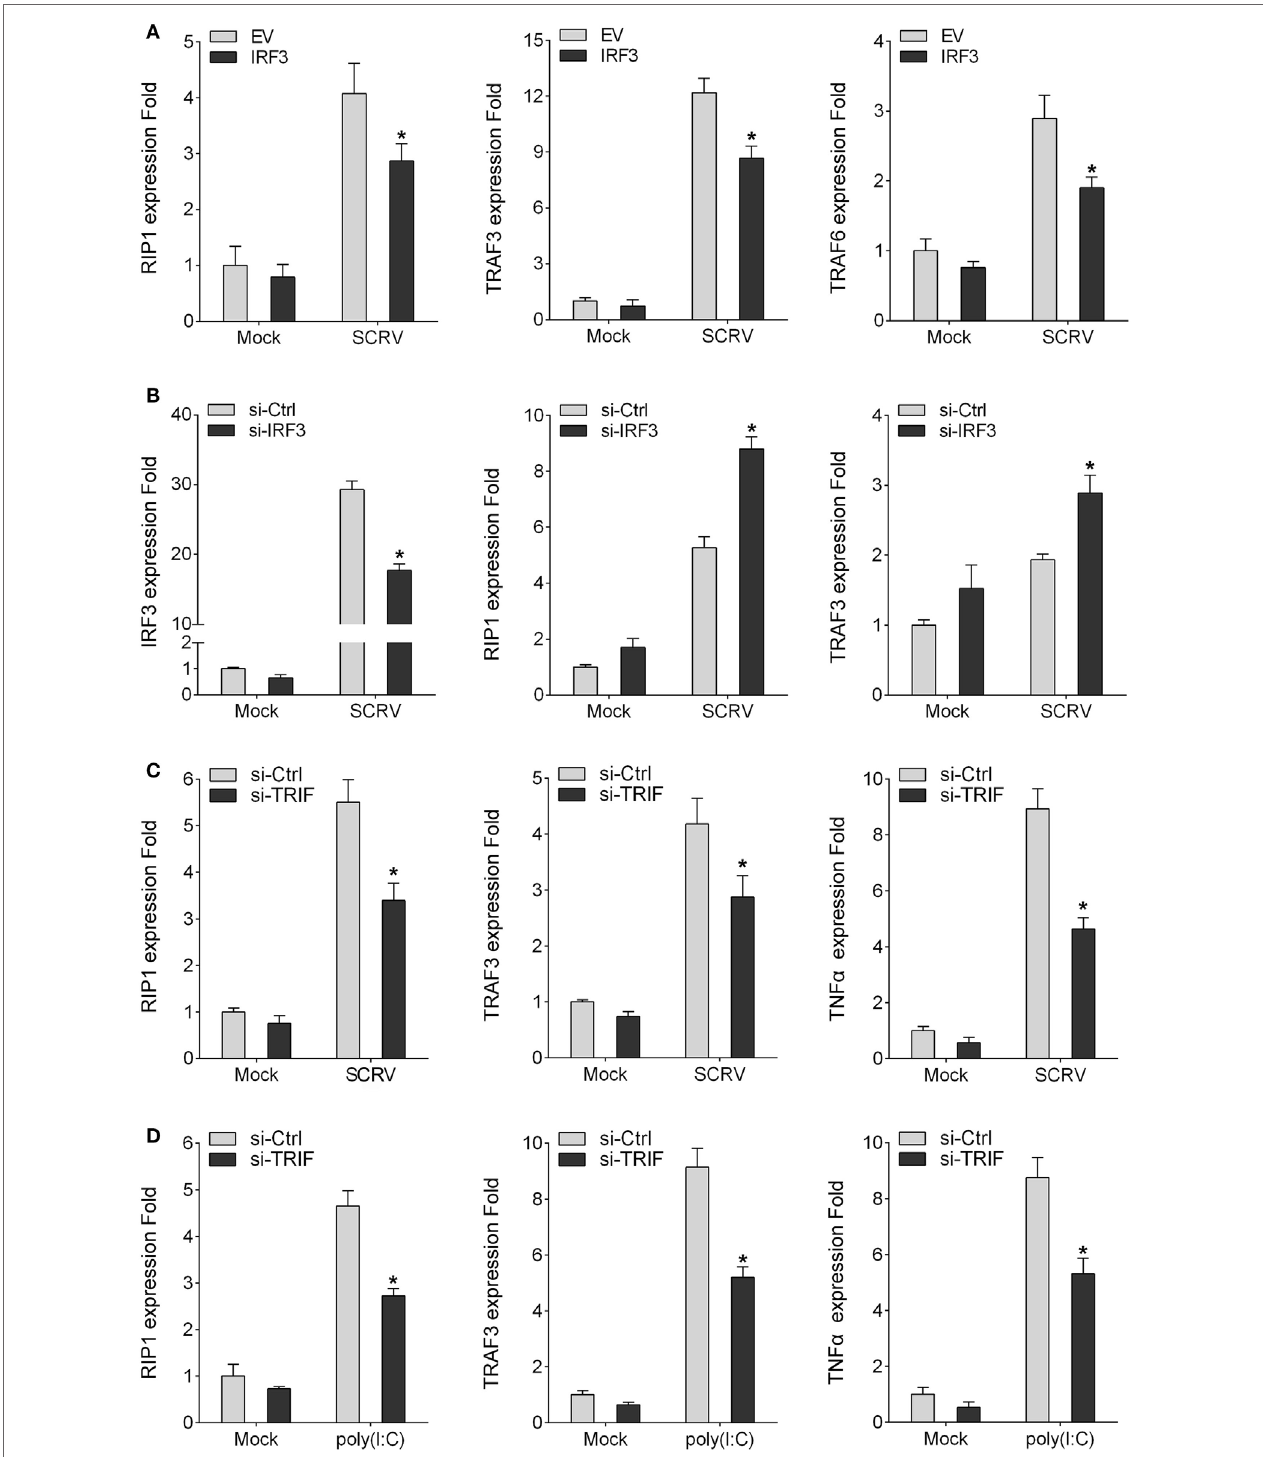
FigUre 5 | IRF3 affects TRIF downstream molecules. (a) MKC were seeded onto 24-well plate overnight and transfected with empty vector or IRF3, after 36 h, infected with SCRV for 12 h, then total RNAs were extracted to examine expression of RIP1, TRAF3, and TRAF6 by qRT-PCR. (B) Miiuy croaker macrophages were transfected with the scrambled control RNA (si-Ctrl) or si-IRF3, after 36 h, infected with SCRV for 12 h, then total RNAs were extracted to examine expression of IRF3, RIP1, and TRAF3 by qRT-PCR. (c,D) Miiuy croker macrophages were transfected with si-Ctrl or si-TRIF. After 36 h, macrophages were then infected with SCRV for 12 h and the expression of RIP1, TRAF3, and TNF α and stimulated with poly(I:C) for another 12 h and the expression of RIP1, TRAF3, and TNF α were determined. * p < 0.05 versus the